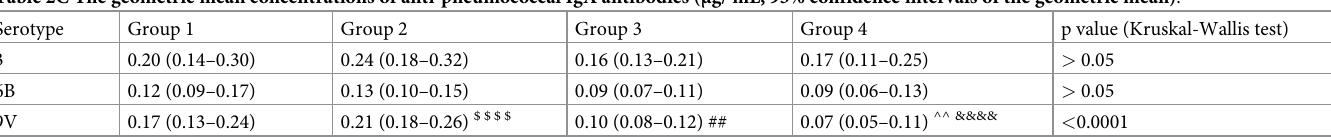
Table 2B The geometric mean concentrations of anti-pneumococcal IgM antibodies ( μ g/ mL, 95% confidence intervals of the geometric mean) . Serotype